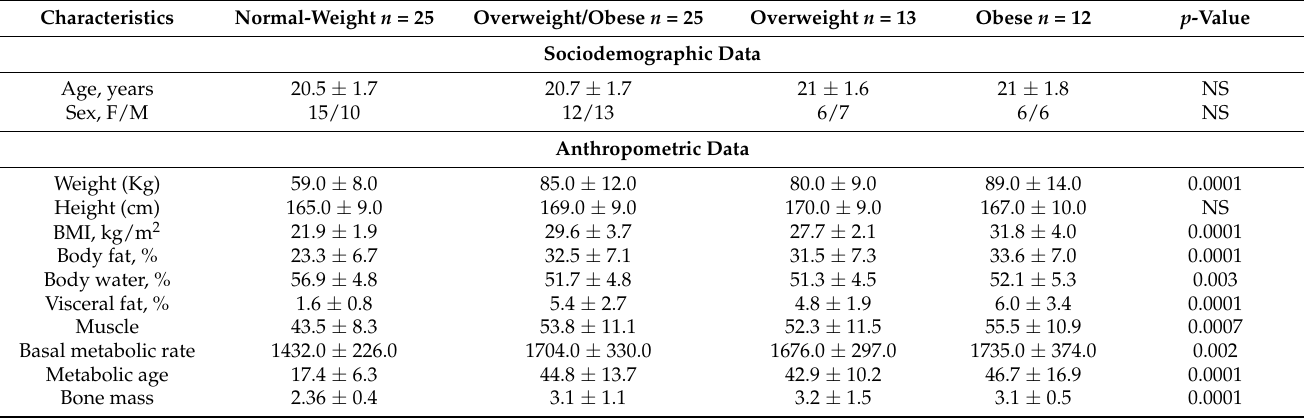
Table 2. Sociodemographic and anthropometric characteristics of the study subjects.